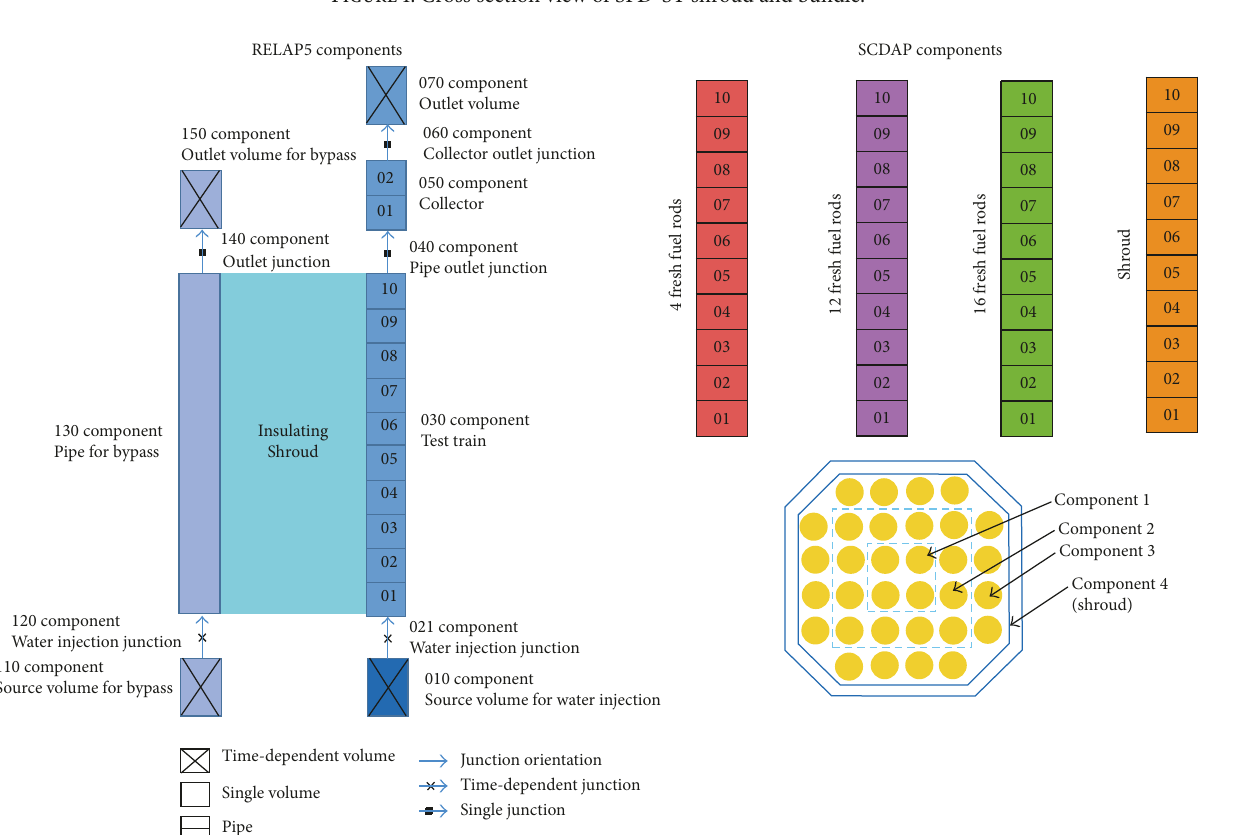
Figure 1: Cross section view of SFD-ST shroud and bundle.